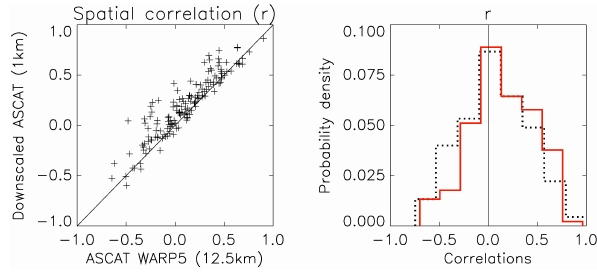
Fig. 6. Spatial correlation between ASCAT SSM estimates and in situ SSM vs. spatial correlation between downscaled ASCAT SSM estimates and in situ SSM, 150 ASCAT swaths (i.e. days) are con- sidered: (left) scatterplot, (right) probability densities of for the ASCAT SSM (dotted line), and for the downscaled ASCAT SSM (red line).